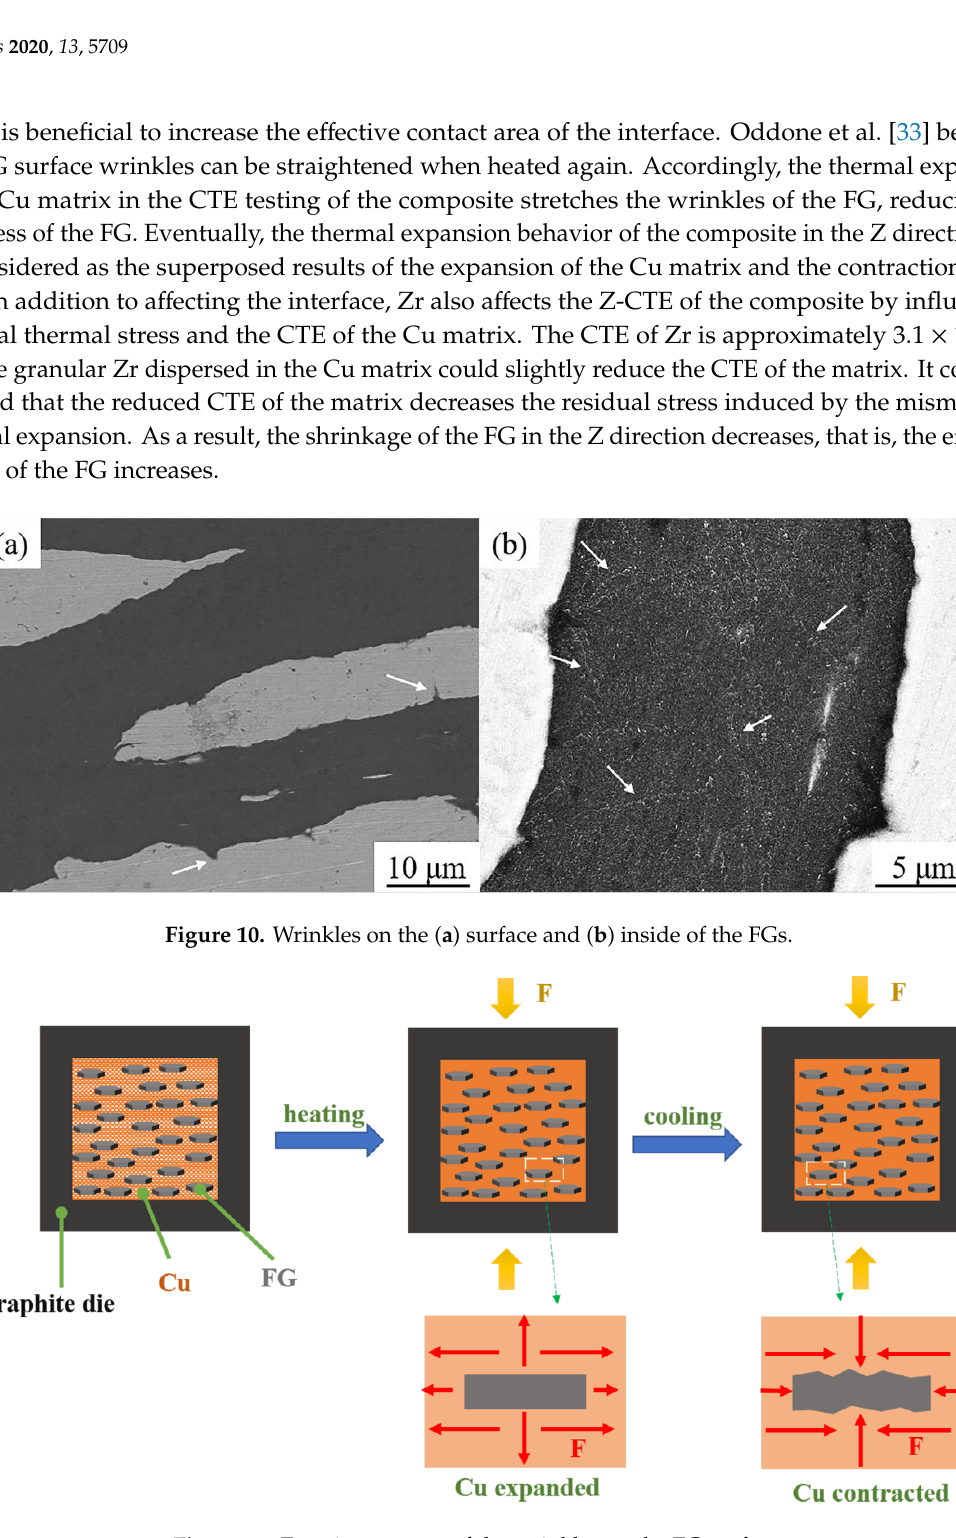
Figure 11. Forming process of the wrinkles on the FG surface.